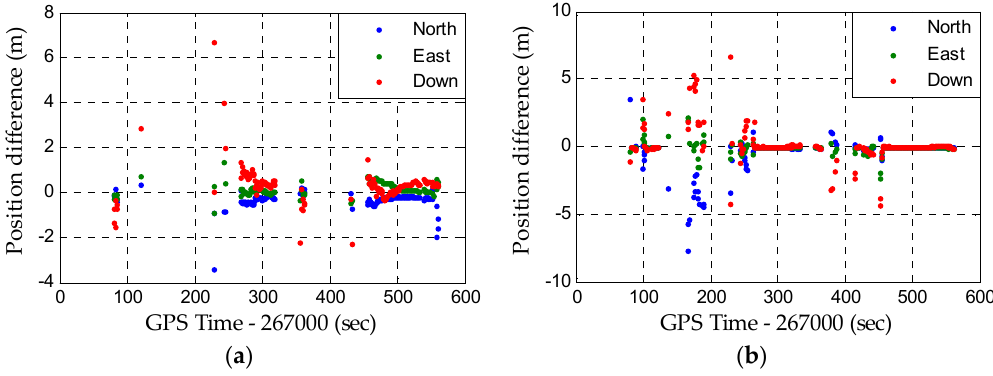
Figure 7. Position difference of single-frequency RTK results calculated using the commercial software GrafNav 8.7 with respect to the reference: ( a ) GPS; ( b ) GPS + BDS.